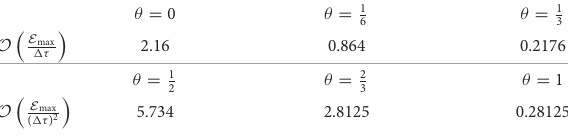
TABLE 1 The order of the consistency of the absolute maximum errors E max of Example 1 for all values of θ .